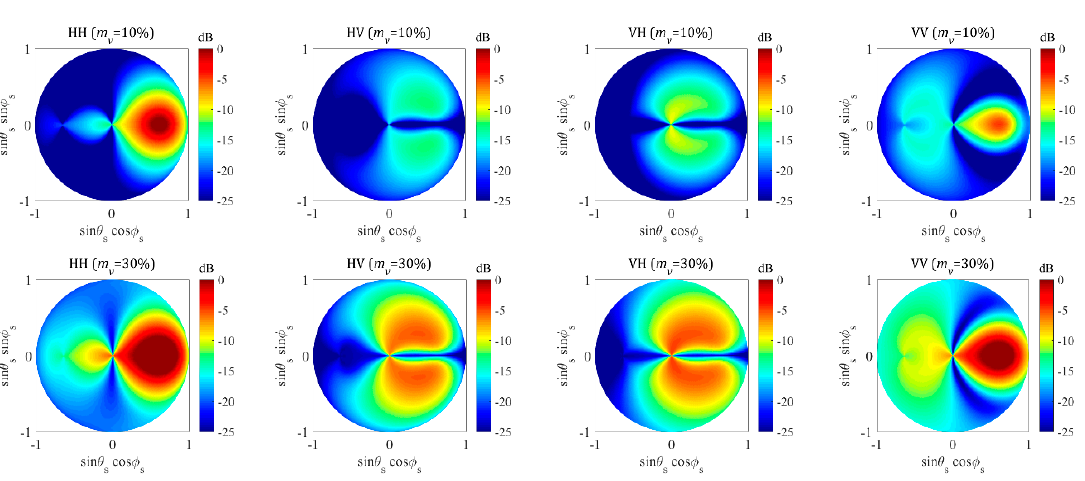
Figure 6. Hemispherical plots of polarized bistatic scattering coefficients HH, HV, VH, and VV, with